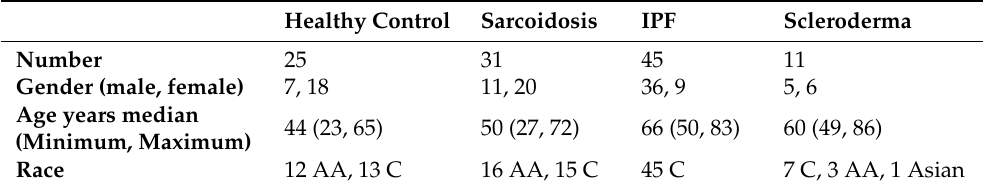
Table 1. Demographic information of the sarcoidosis, IPF, and scleroderma patients and the healthy control subjects used in this study. Healthy Control Sarcoidosis IPF